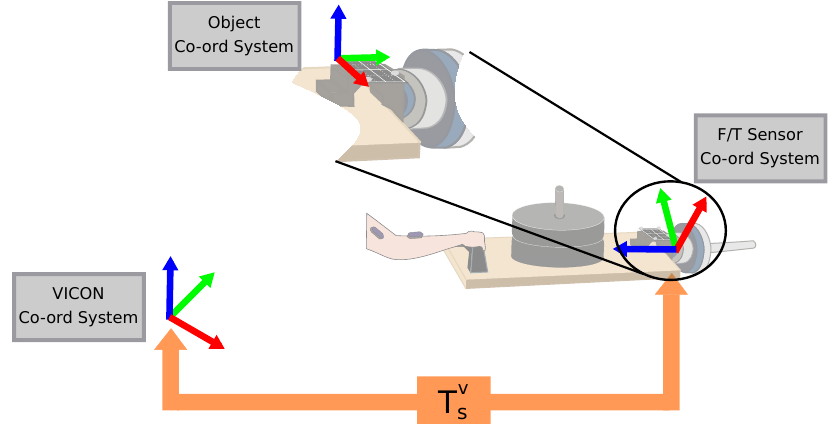
Figure 5. Coordinate system transformations: F/T sensors into VICON